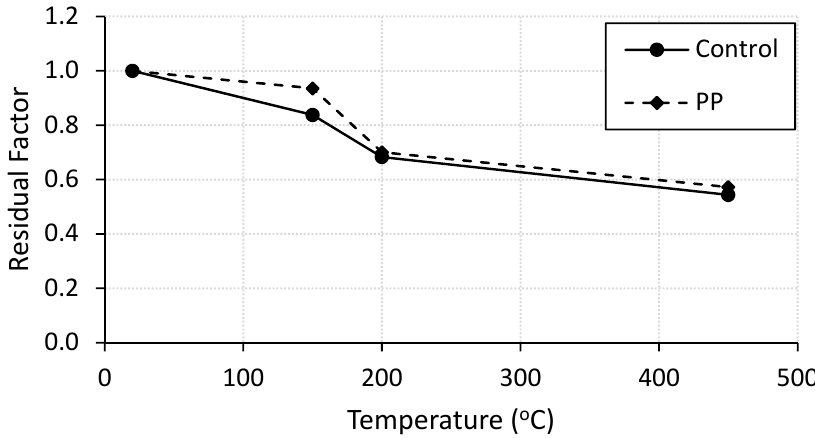
Figure 5. Residual elastic modulus factor for control and fiber-reinforced specimens.